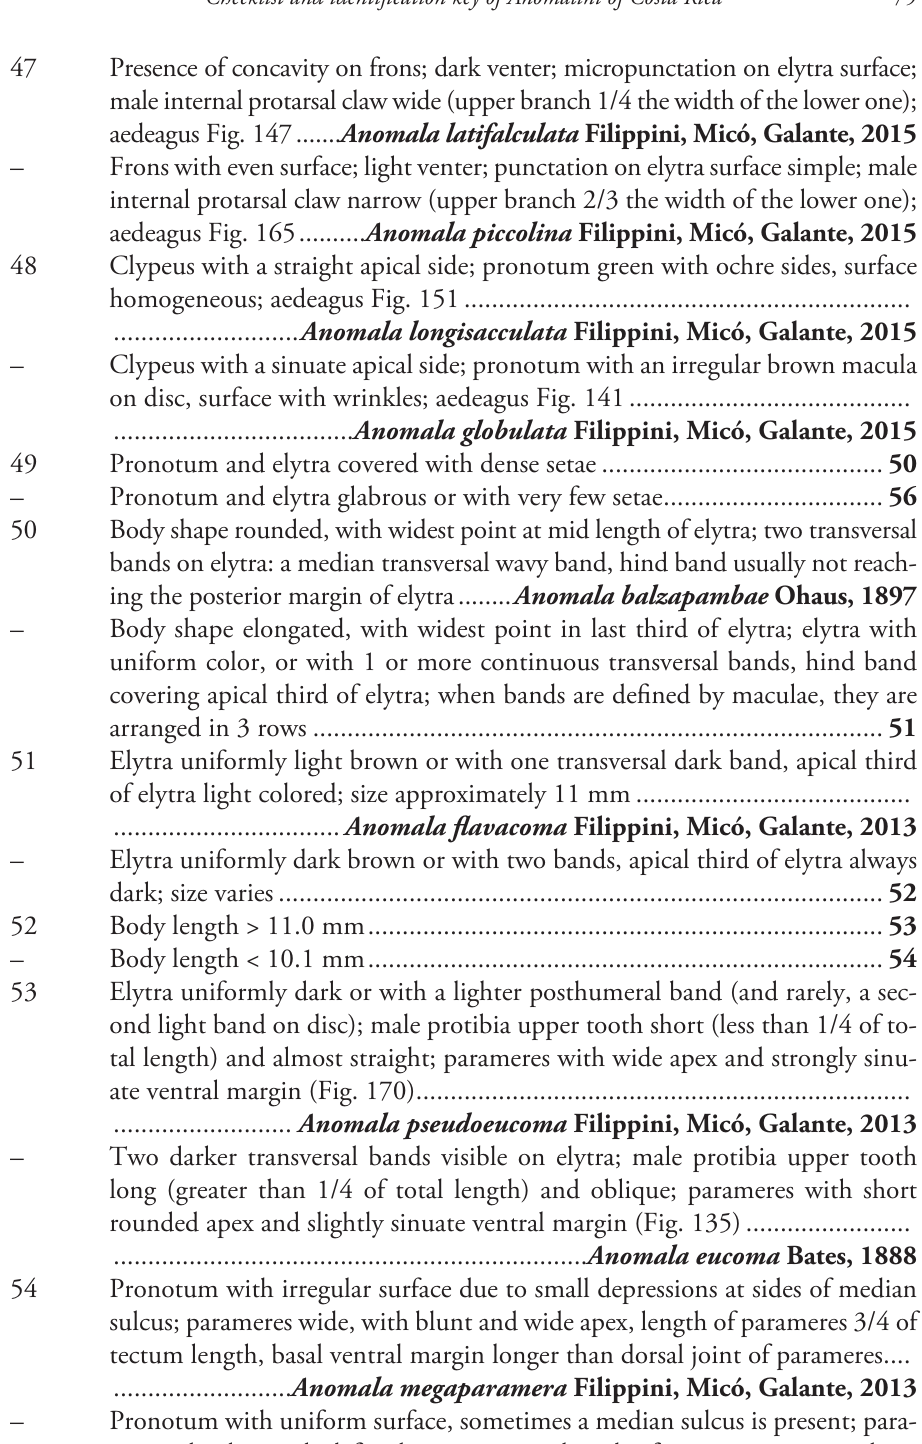
– Two darker transversal bands visible on elytra; male protibia upper tooth long (greater than 1/4 of total length) and oblique; parameres with short rounded apex and slightly sinuate ventral margin (Fig. 135) ........................ 54 Pronotum with irregular surface due to small depressions at sides of median sulcus; parameres wide, with blunt and wide apex, length of parameres 3/4 of tectum length, basal ventral margin longer than dorsal joint of parameres .... – Pronotum with uniform surface, sometimes a median sulcus is present; para- meres slender, with defined narrow apex, length of parameres not